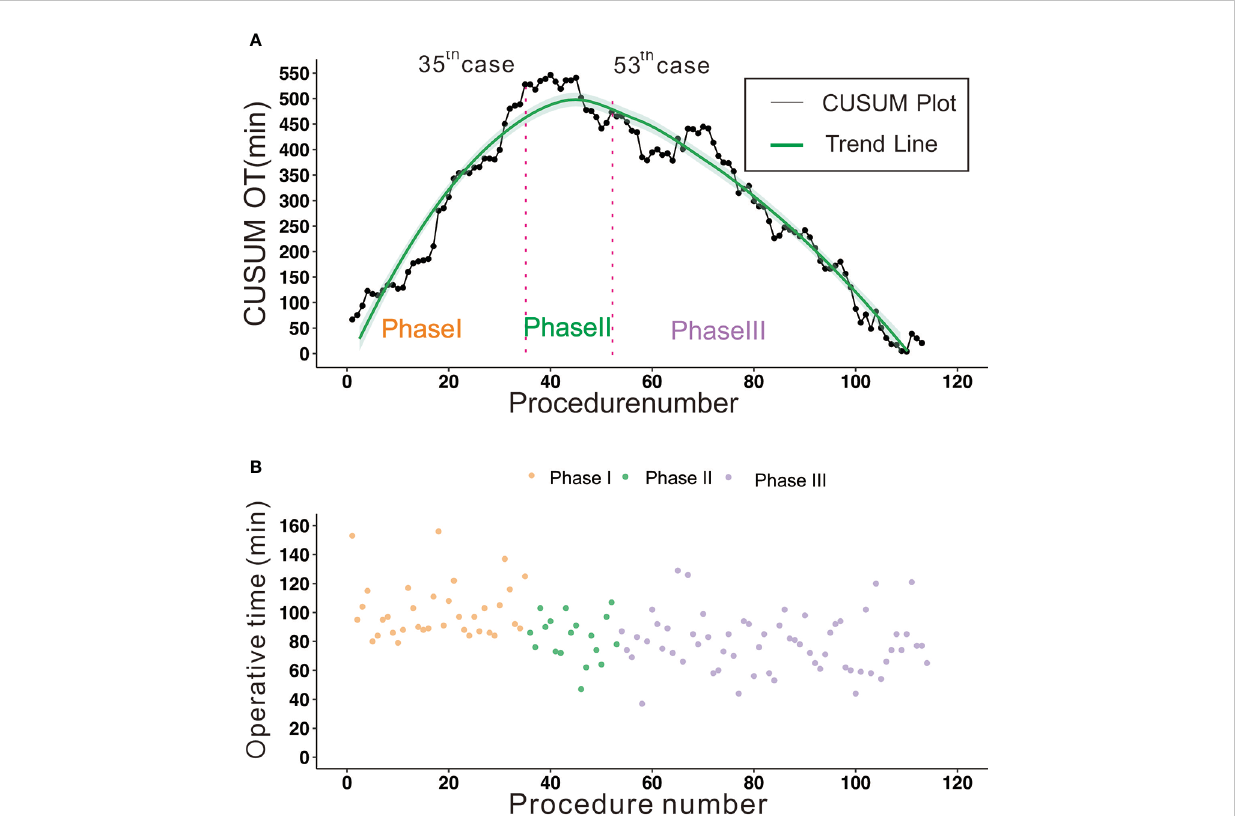
FIGURE 1 (A) The CUSUM curve of operative time; 35 cases were needed to lay the technical foundation and 53 cases were necessary to achieve pro fi ciency. Phase I: 1-35 cases, learning phase. Phase II: 36-53 cases, transition phase. Phase III: 54-114 cases, pro fi ciency phase. (B) The raw operative times were plotted in chronologic surgery